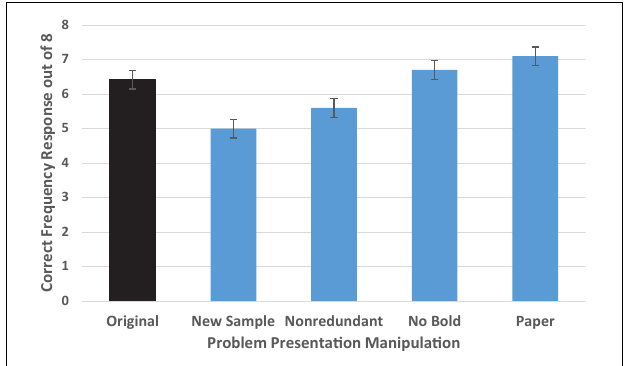
FIGURE 7 | Experiment 2 condition accuracy means while controlling for numeracy. Error bars indicate ± 1